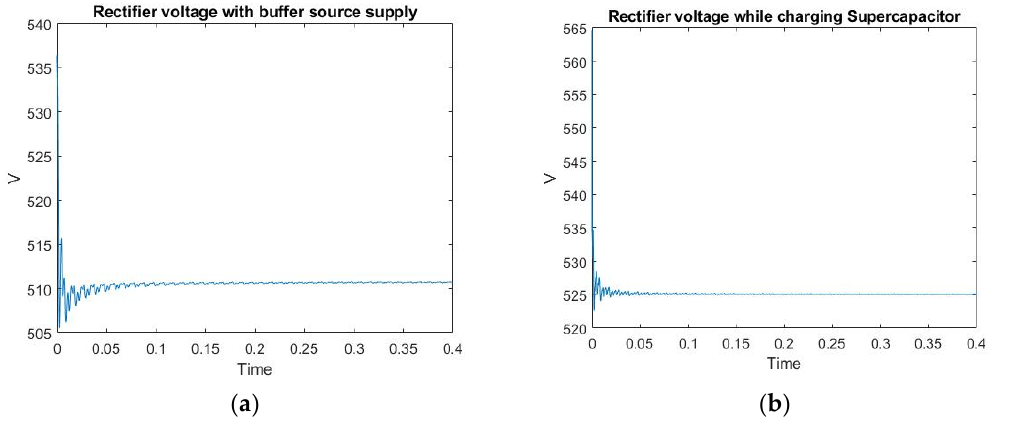
Figure 18. Voltage at the rectifier: ( a ) using supercapacitor and ( b ) charging supercapacitor.